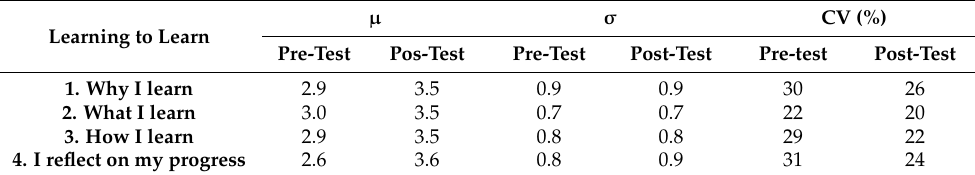
Figure 9. Levels of achievement of the fourth dimension: I reflect on my progress (%). In general, in relation to the four dimensions that were analyzed, after the outdoor experience, the ECPT reached levels III and IV in the post-test. This translates—along with Table 4. Acquiring learning to learn competence (pre-test–post-test): Descriptive the results of the rubrics for the evaluation of the students—into an improvement in self- confidence, teamwork and collaboration, enthusiasm, responsibility, planning, new chal- lenges, completion of tasks on time, and successful goals. Numerical and percentage data were reinforced with descriptive statistic measures, including the mean or average (µ), standard deviation ( σ ), and coefficient of variation (CV). These parameters contributed very significant figures. Level III (pre-test) and level IV (post-test) prevailed in all four dimensions (Table 4).